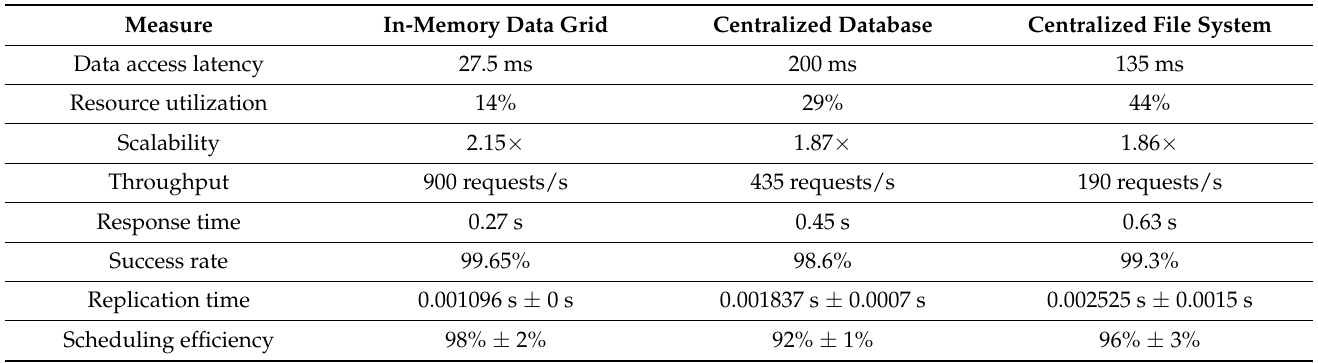
Table 11. Comparison of the performance measures of the